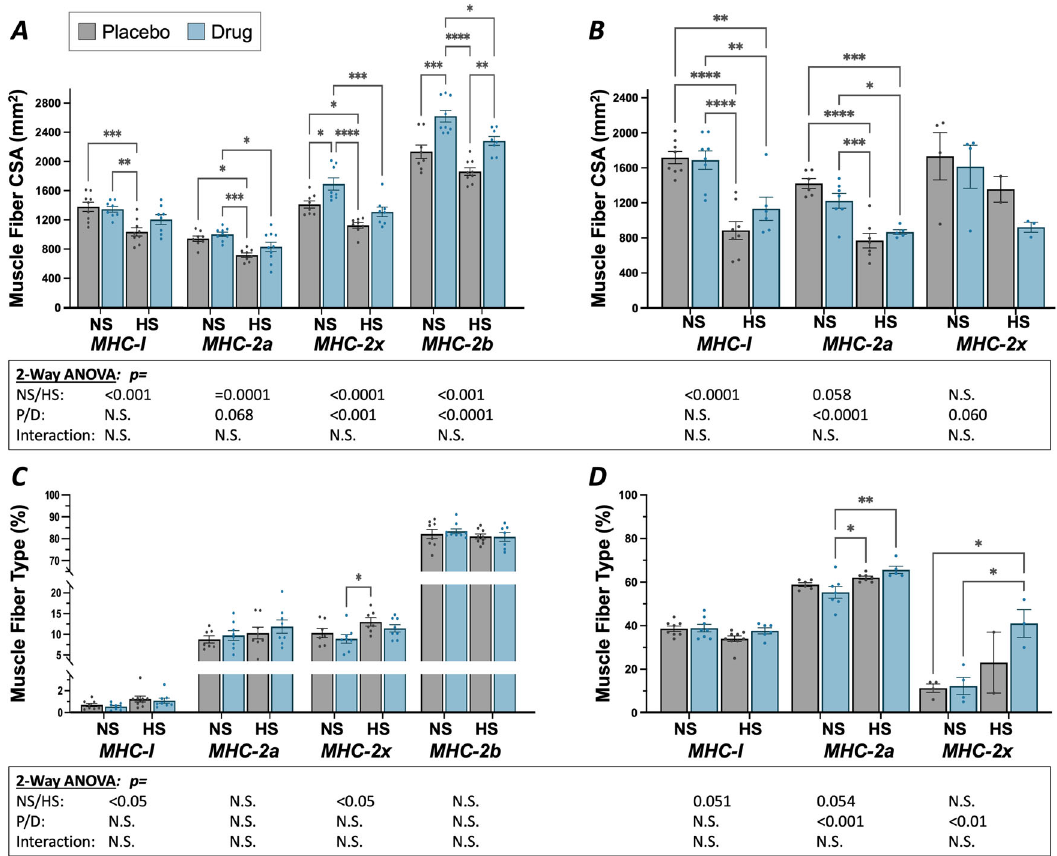
Fig. 5 Muscle fi ber cross-section area (CSA) and fi ber type analyses of MHC isoform expression. A , C Gastrocnemius and B , D soleus muscles, respectively. A two-way ANOVA revealed highly signi fi cant effect of HS on CSA for both the gastrocnemius and soleus for nearly all fi ber types ( p < 0.001, exception was soleus Type IIx fi bers). Posthoc Tukey ’ s comparisons demonstrated signi fi cant differences as indicated by dissimilar letters. Overall, group-wise comparisons in the gastrocnemius revealed a reduction in most fi ber types with hindlimb